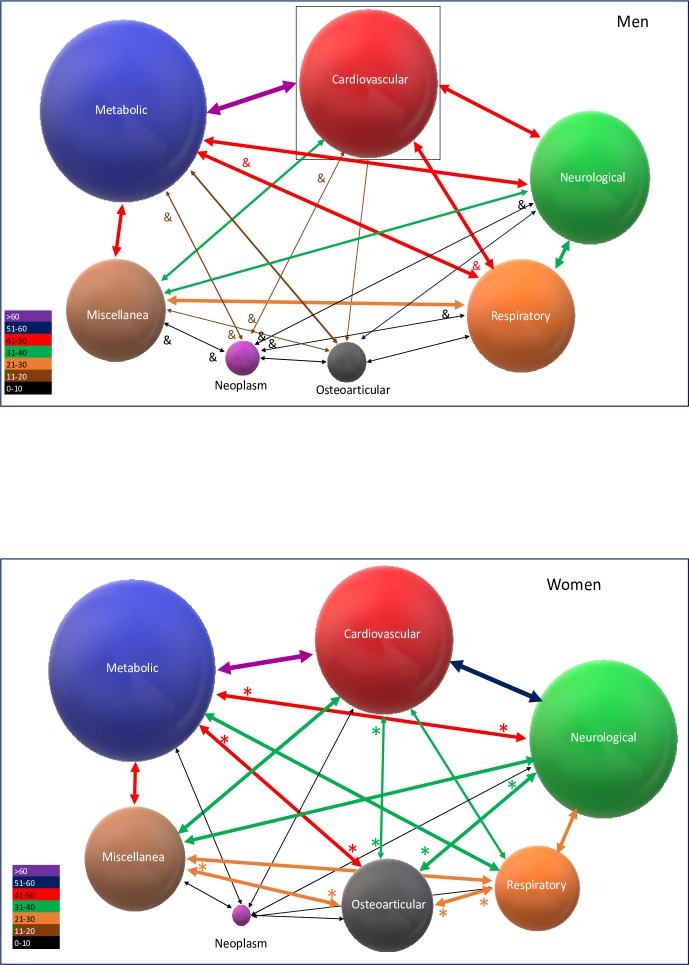
The diameter of the spheres represents the prevalence in pattern percentage, while union lines express the frequency of the relationship.Violet lines >60%, Blue lines 51–60%, Red lines 41–50%, Green lines 31–40%%, Orange lines 21–30, Brown lines 11–20%, Black lines <11%. * The association between patterns is statistically significantly higher in men than in women. & The association between patterns is statistically significantly higher in women than in men.